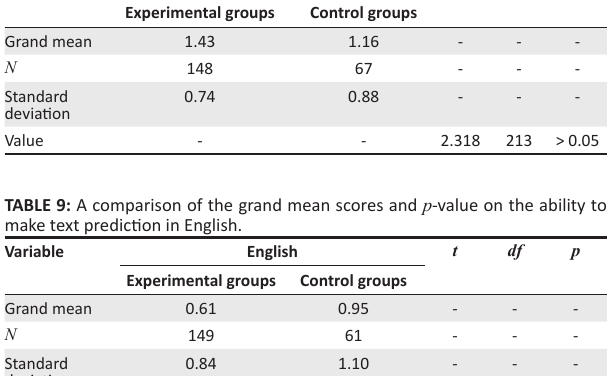
TABLE 8: A comparison of the grand mean scores and p -value on the ability to make text prediction in isiXhosa. Variable